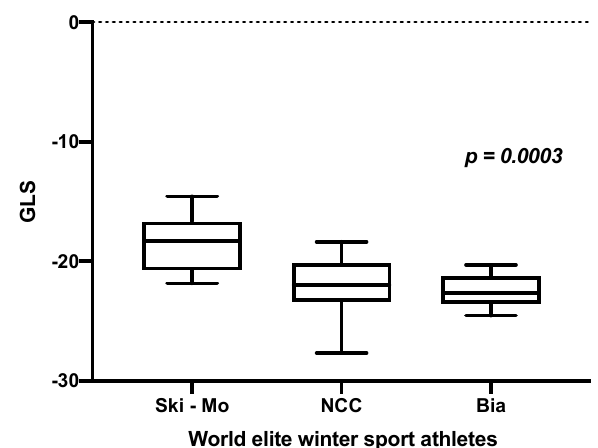
Figure 2. Analysis of the left ventricular global longitudinal strain (GLS) in world elite winter sport professionals ( p = 0.0052), modified from Zimmermann et al. 2021 [12].